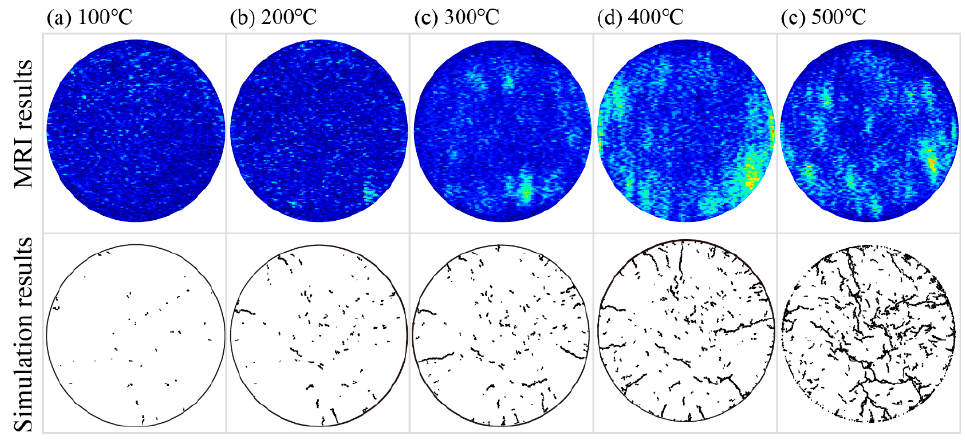
Figure 10. Comparison of MRI results and simulation results.